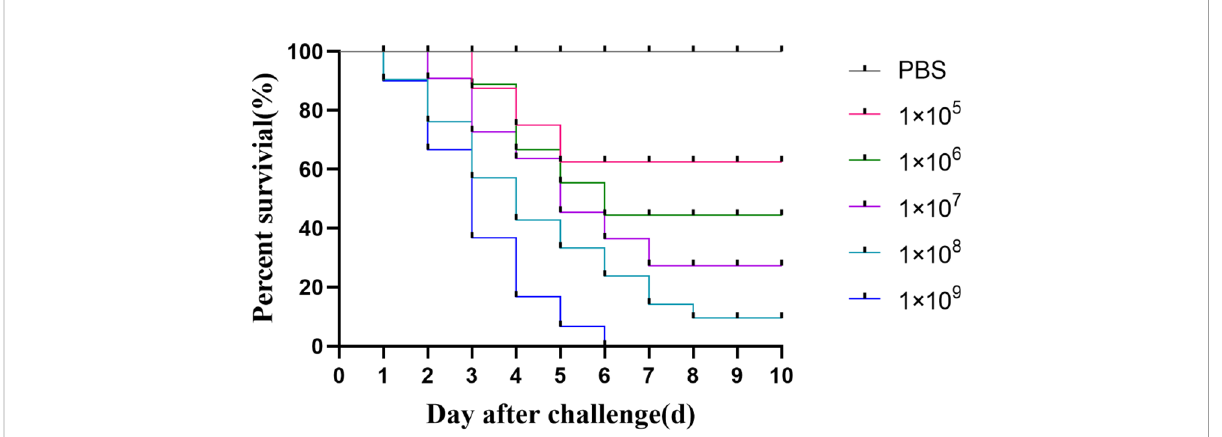
FIGURE 5 Regression infection analysis of D-59. Survival of hybrid sturgeon by injection of different concentrations of D-59 strain: The control group was injected intraperitoneally with 0.3 mL of sterile PBS, and the test group was injected intraperitoneally with 0.3 mL of 1 × 10 5 CFU/mL,1 × 10 6